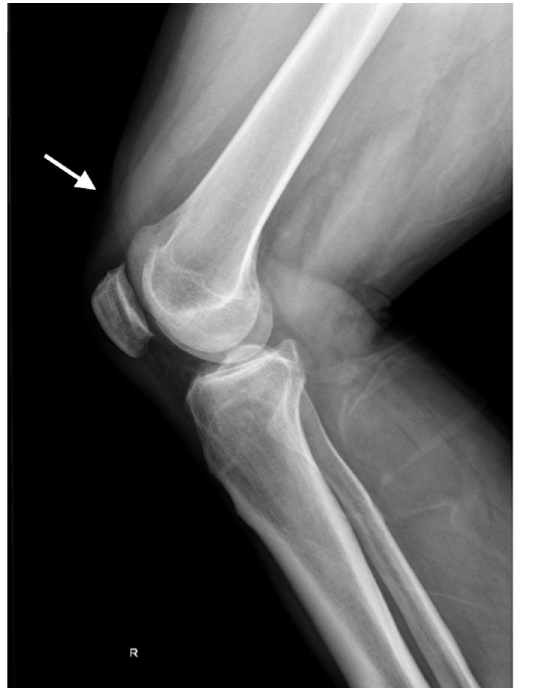
Image 1. Plain radiograph of the right knee demonstrating mild suprapatellar soft tissue swelling